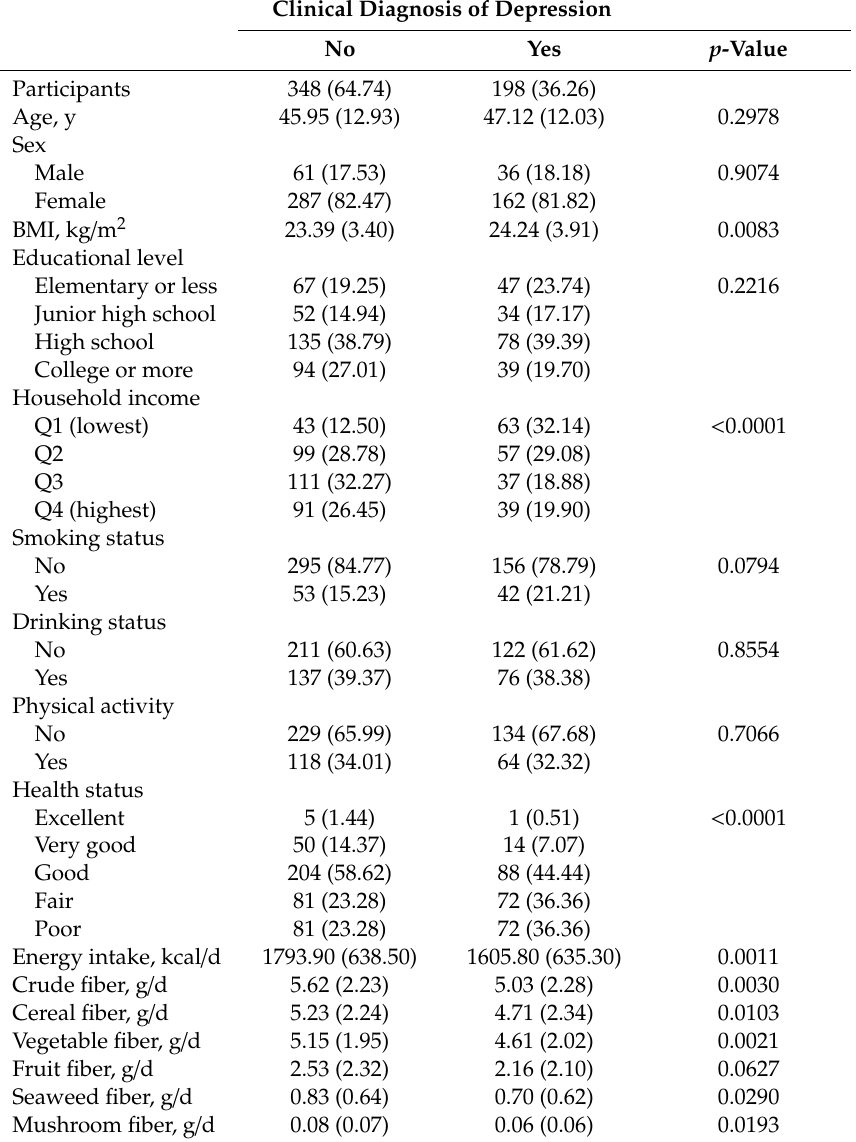
Table A1. General characteristics